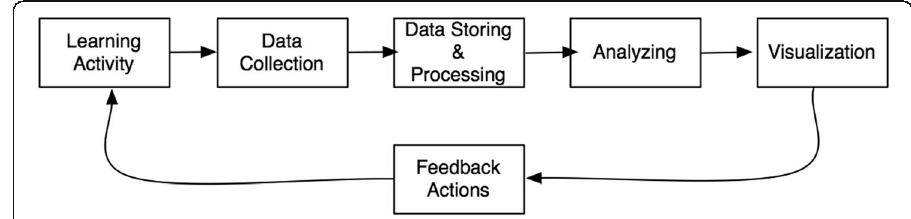
Fig. 4 LA process model developed by ISO/IEC JTC1/SC36 (ISO